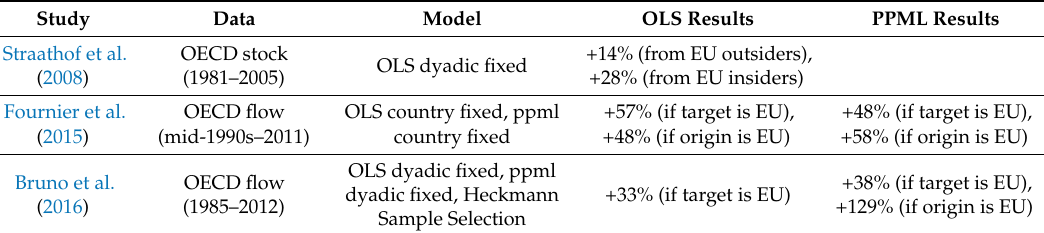
Table 1. EU-membership and its effect on FDI; gravity